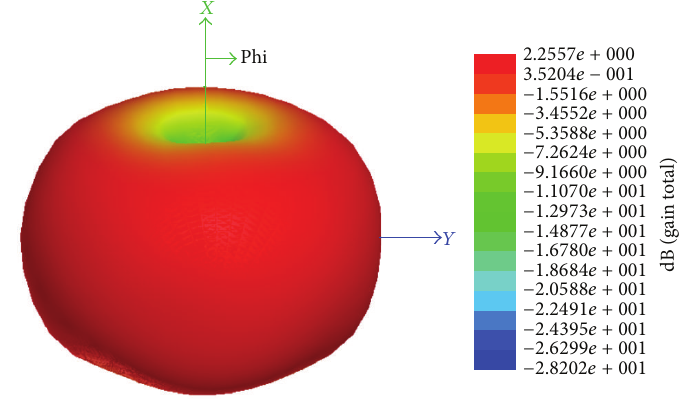
Figure 10: Three-dimensional radiation pattern.